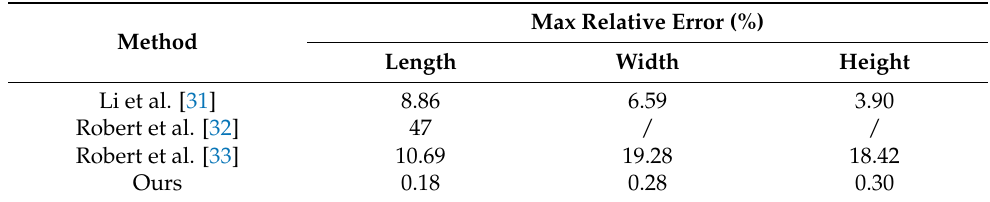
Table 3. The experimental results of our measurement method and the three reference comparison methods.